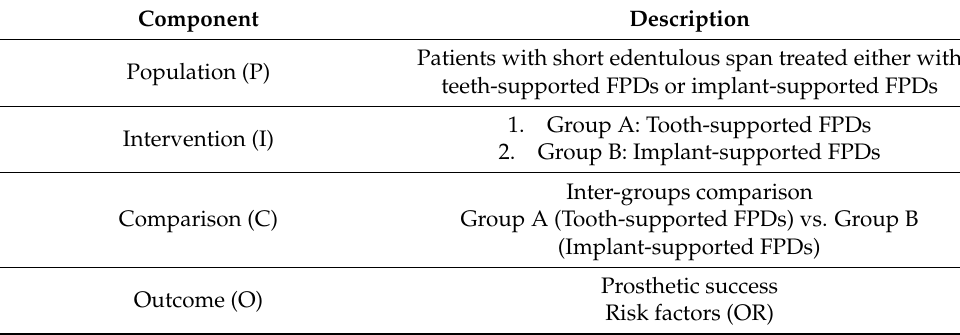
Table 1. Study design (PICO).